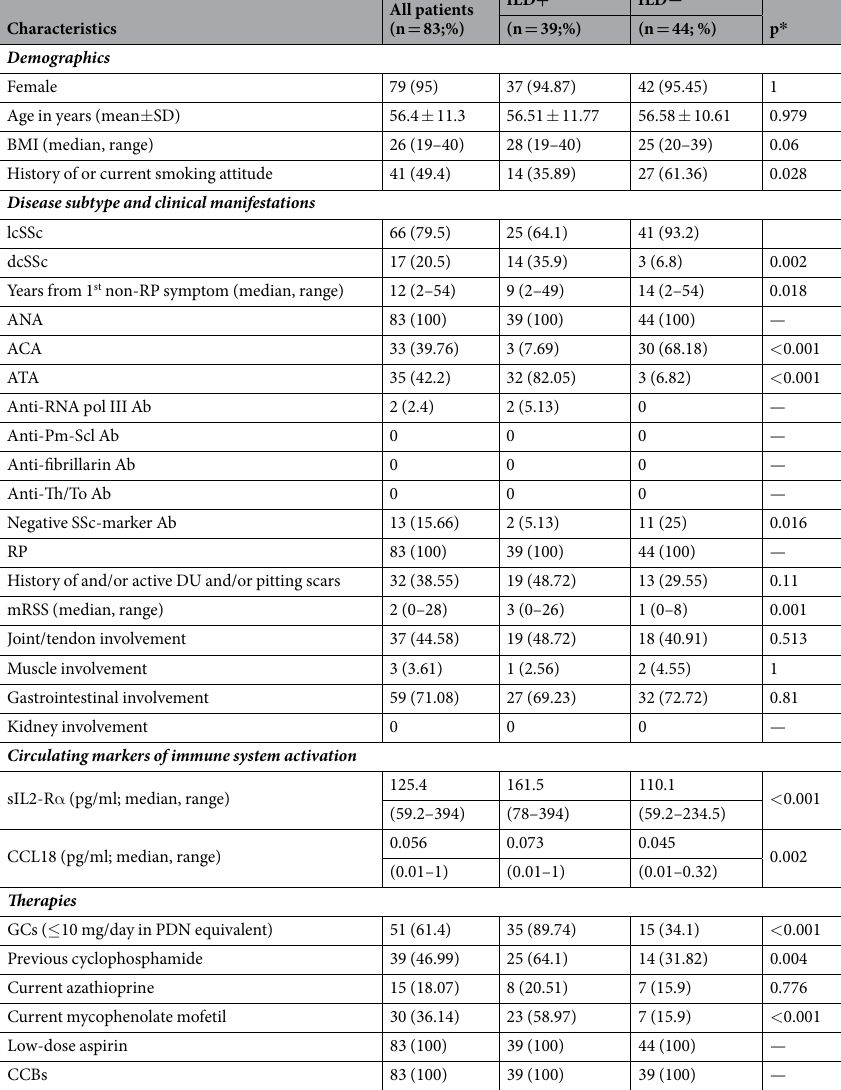
Table 1. Characteristics of the SSc patients at baseline. Data are number and percentages (in brackets) except where otherwise indicated. SSc = systemic sclerosis; ILD = interstitial lung disease; SD = standard deviation; BMI = body mass index; lcSSc = limited cutaneous systemic sclerosis; dcSSc = diffuse cutaneous systemic sclerosis; RP = Raynaud phenomenon; ANA = antinuclear antibodies; ACA = anticentromere antibodies; ATA = anti-topoisomerase-I antibodies; Anti-RNA pol III = anti-RNA polymerase III; Ab =